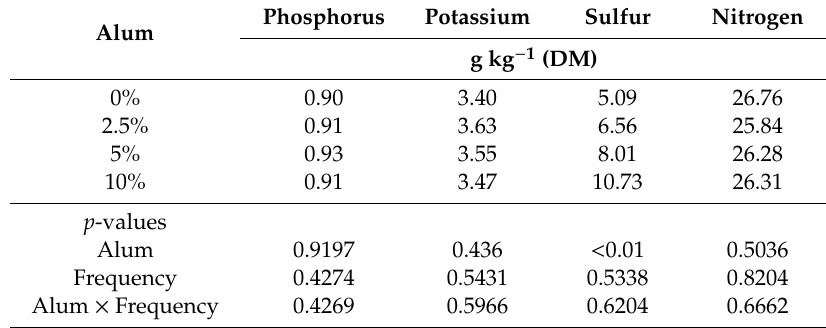
Table 2. Average nutrient composition of the bedded packs at Day 42, following the addition of